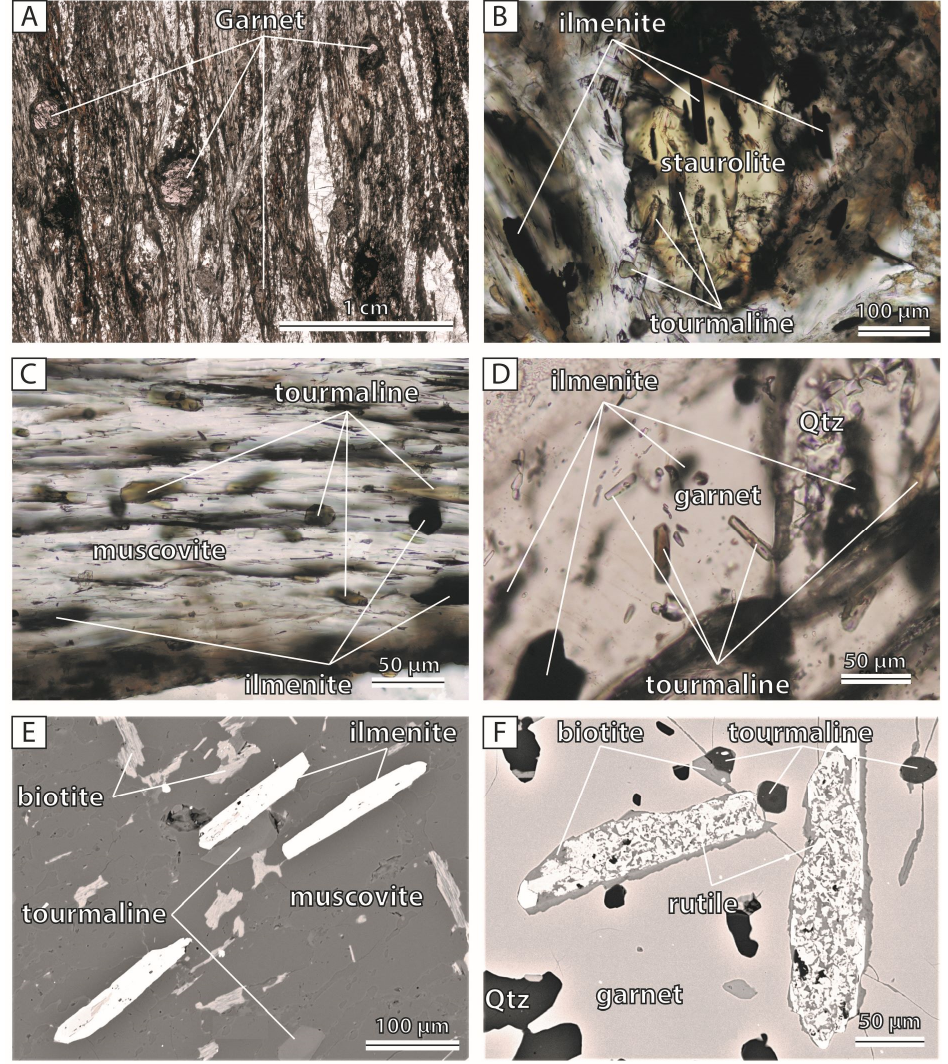
Figure 8 . Photomicrographs illustrating the metamorphic assemblage in the La Bosse stockwork host rock. ( A ): texture of the schist host rock (thick section high resolution scanning). ( B ): Tourmaline and ilmenite inclusions in staurolite (PPL). ( C ): Muscovite in schist containing inclusions of ilmenite and tourmaline rods, oriented parallel to its cleavage (PPL). ( D ): details of a garnet porphyroblast showing inclusions of randomly oriented tourmaline and ilmenite crystals (PPL). ( E ), ( F ): BSE images of ilmenite and tourmaline occurring as inclusions in muscovite (plus minor biotite) ( E ) and garnet ( F ). lmenite in garnet shows strong alteration to rutile plus biotite.